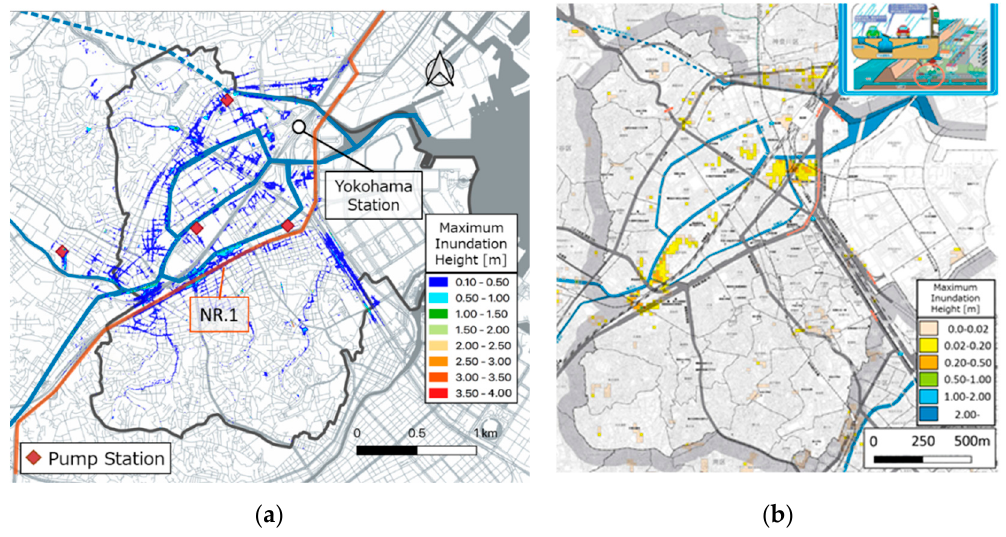
Figure 12. Comparison of inland flooding: ( a ) inland water analysis result; and ( b ) report on the inland water hazard map production.